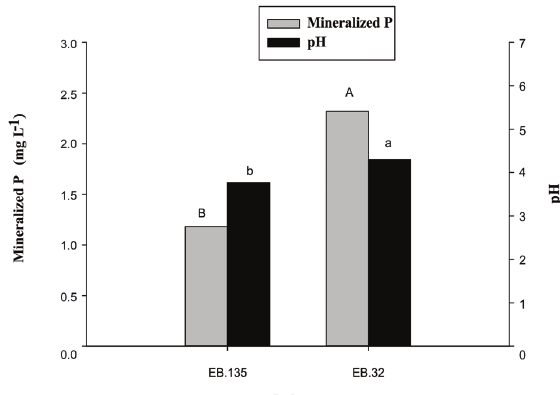
Figure 4 - Average pH and mineralized P (mg L -1 ) in NBRIP medium supplemented with soy lecithin for endophytic bacteria isolated from “Prata Anã” banana tree roots. (Vertical bars represent the standard error). The means followed by the same upper and lower case letters indicate they belong to the same group through the Scott-Knott test at a significance level at P < 0.05.